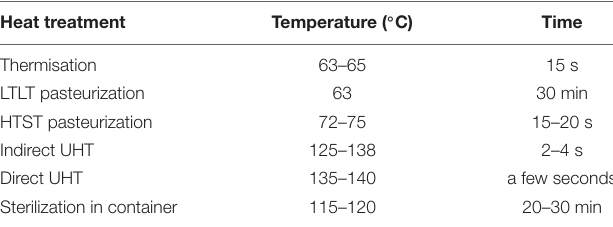
TABLE 1 | The different combinations of temperature and time of heat treatments applied by the dairy industry to milk